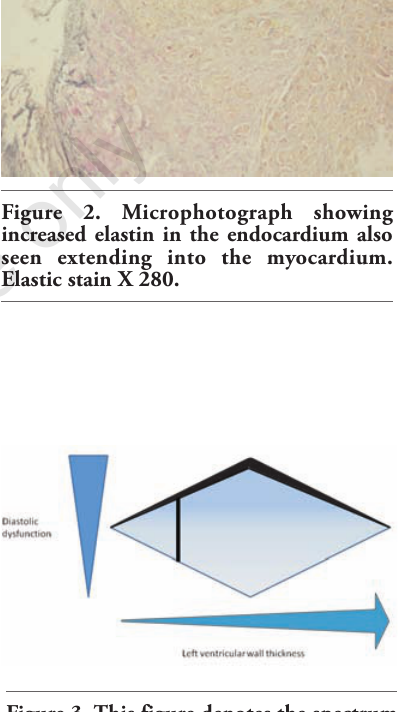
Figure 3. This figure denotes the spectrum of hypertrophic/ idiopathic restrictive car- diomyopathy. Increase in left ventricular wall thickness is denoted on the X axis with increasing wall thickness from left to right. In the diagonal normal left wall thickness would be on the left of the figure and severe hypertrophy on right. The verti- cal black line indicates the cut off between normal ventricular wall thickness on the left and left ventricular hypertrophy on the right of the line. Hypertrophic cardiomy- opathy is a disorder of diastolic dysfunc- tion. Progressive increase of diastolic dys- function is denoted on the Y axis. The black band at top of the diagonal repre- sents patients at the extreme end of dias- tolic dysfunction that is restrictive physiol- ogy. Patients with restrictive physiology and normal left ventricular wall thickness (to the left of the vertical black line) are labelled idiopathic restrictive cardiomy- opathy. Patients with restrictive physiology and increased left ventricular wall thick- ness (to the right of the vertical black line) are labelled hypertrophic cardiomyopathy with restrictive